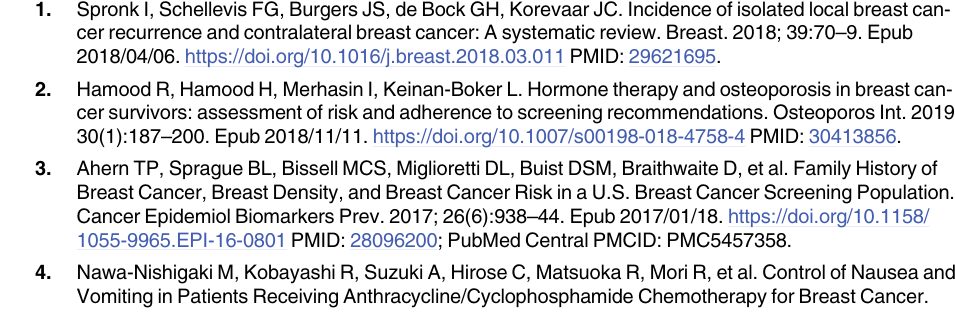
S2 Fig. Effects of CUN on the intracellular Fe 2+ expression. Both BC cells were preincubated with DFO (50 μ M), for 2 h followed by CUN treatment for 48 h. A, B: The intracellular Fe 2+ expression in both BC cell lines was measured by an iron assay kit. �� P < 0.001, compared with the CUN group. CUN, curcumin; BC, breast cancer; DFO, deferoxamine. S3 Fig. Effects of curcumin on gene expression. A and B: qRT-PCR was used to examine the mRNA expression levels of SLCA5 and SLC38A1. ### P < 0.001. compared with the control group. S1 Raw images. Raw data images of western blot analysis corresponding to Figs 3 and